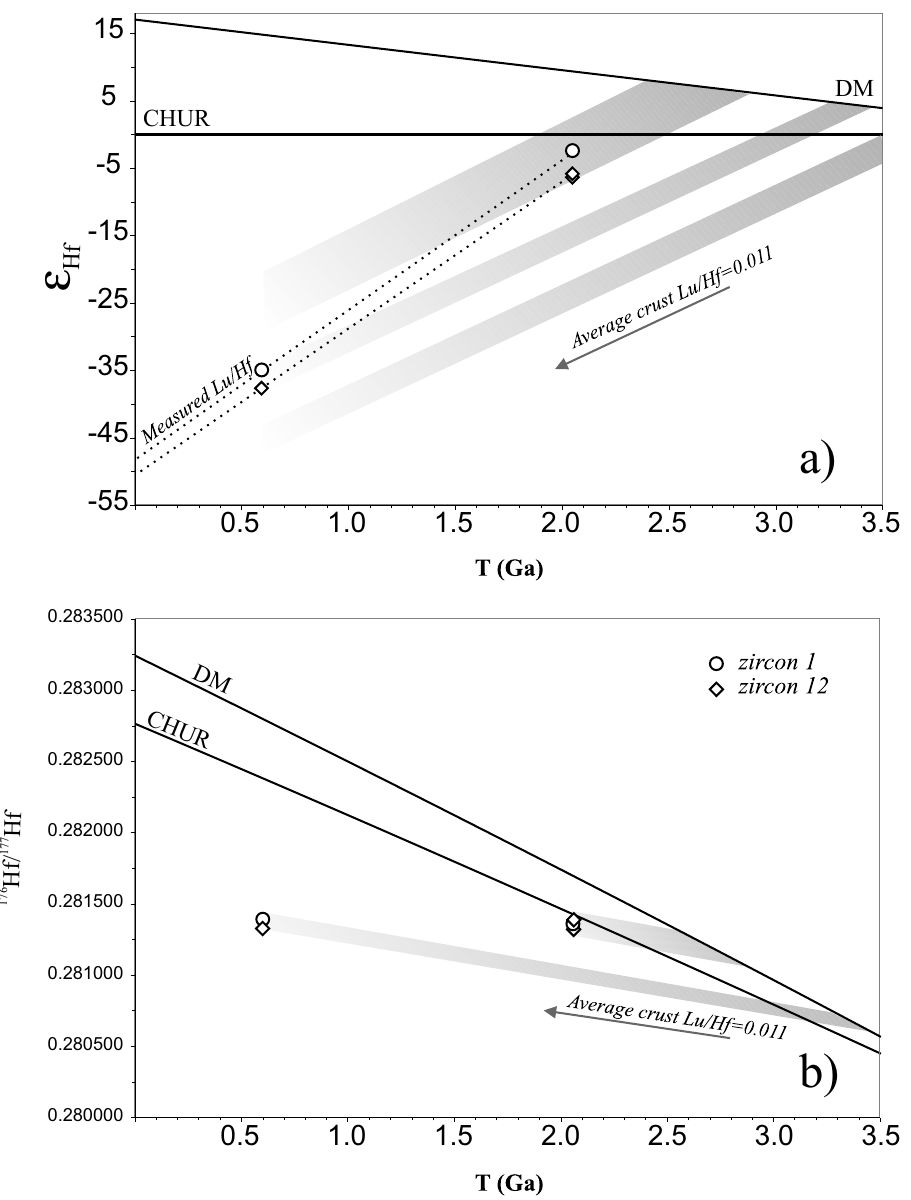
Fig. 5 – ε Hf (a) and Hf isotope (b) evolution diagrams showing the results of Lu-Hf LA-MC-ICP-MS analyses. Shadowed areas indicate the ε Hf(t) bulk-rock evolution trend for terranes of different ages recognised in the Borborema Province (Dantas et al. 2004). Dotted lines (Fig. 5a) indicate the ε Hf(t) evolution for zircons crystallized at ∼ 2 Ga, calculated from measured